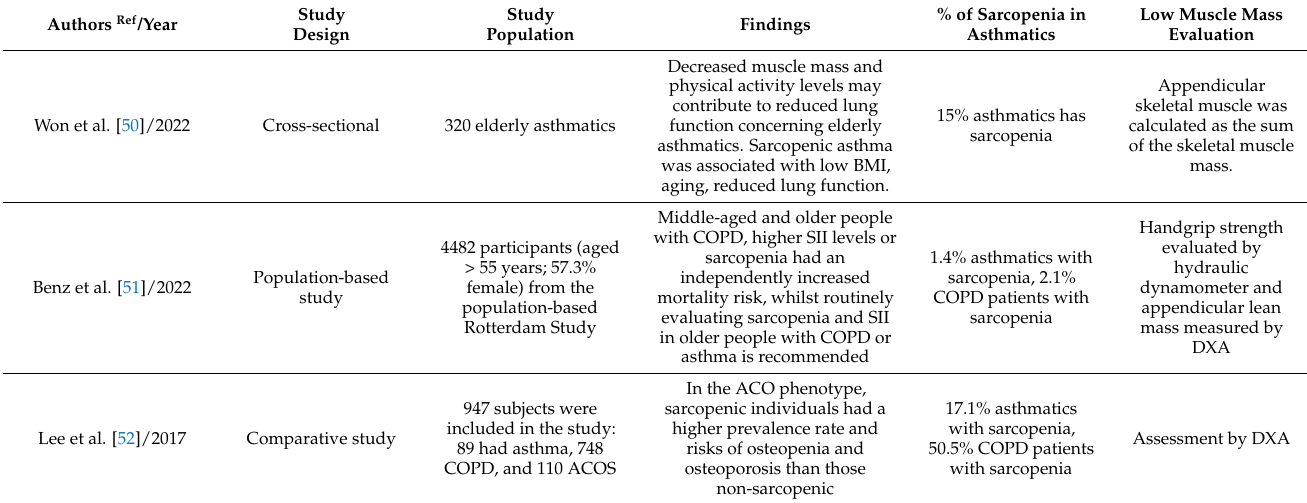
Table 1. The interplay between sarcopenia and bronchial